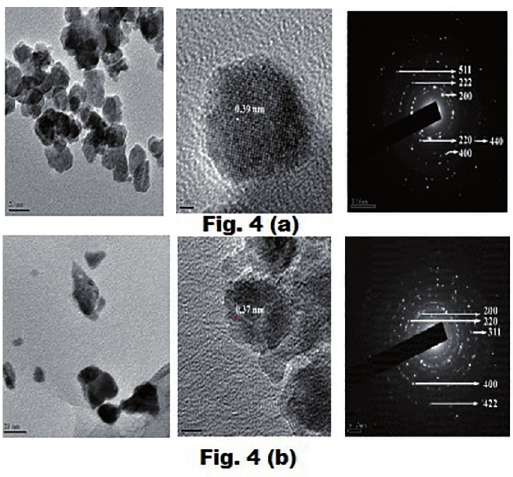
Figure 4: TEM, HRTEM and SAED (Selected Area Electron Diffraction) patterns of In